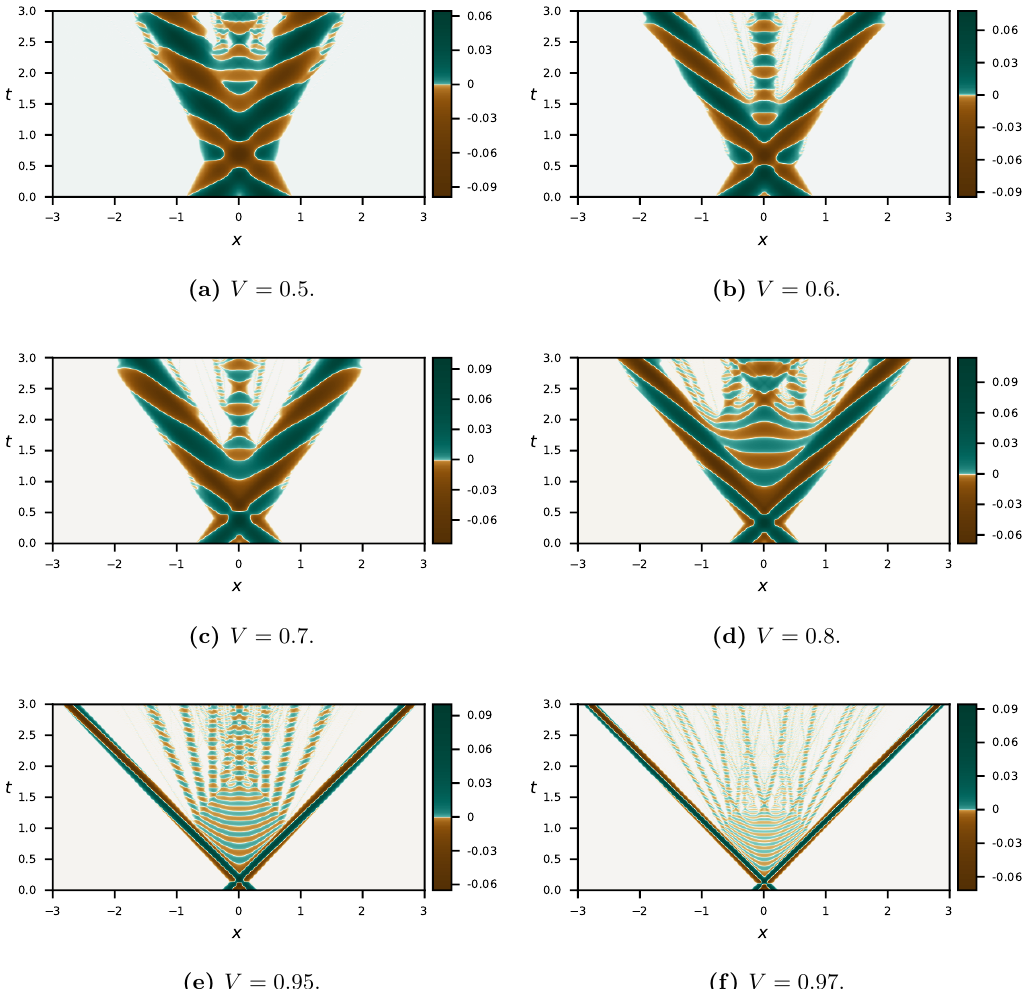
Figure 17 . The scatterings of oscillons (symmetric con(cid:12)guration) as a function of their initial speed V . The initial con(cid:12)gurations contain oscillons with phase (cid:11) = 0 and no zig-zag motion of their border v =